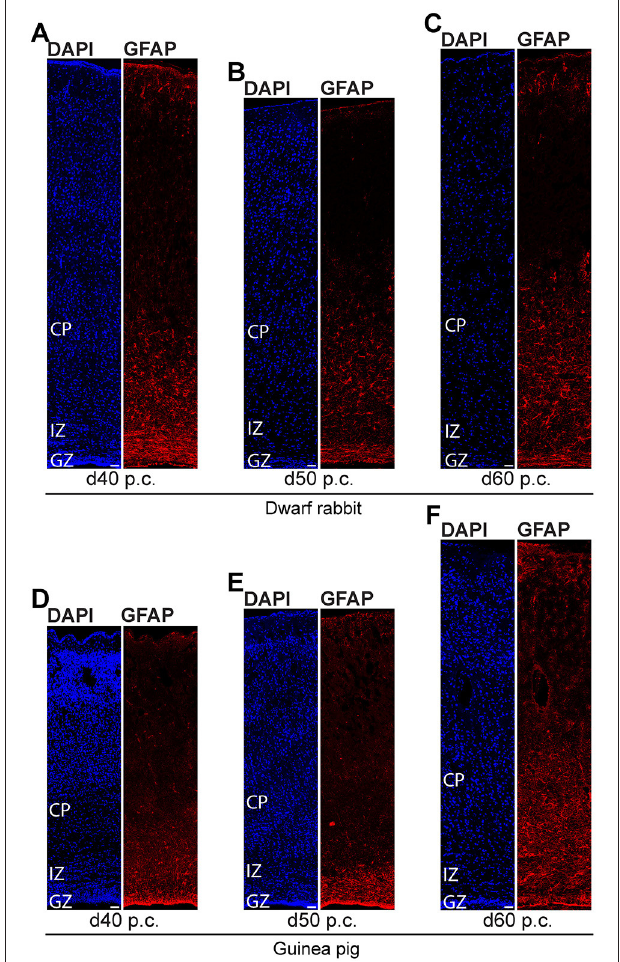
FIGURE 11 | GFAP expression in the developing dwarf rabbit neocortex and guinea pig neocortex. Immunofluorescence for GFAP (red) and DAPI staining (blue) on 30- µ m cryosections of day 40–60 post-conception (d p.c.) dwarf rabbit (A–C) neocortex and guinea pig (D–F) neocortex. CP, cortical plate. GZ, germinal zone. IZ, intermediate zone. Scale bars, 50 µ m.